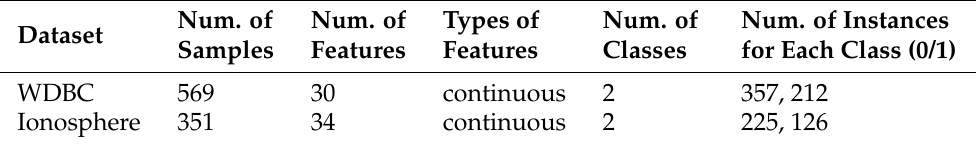
Table 1. The details of the benchmark